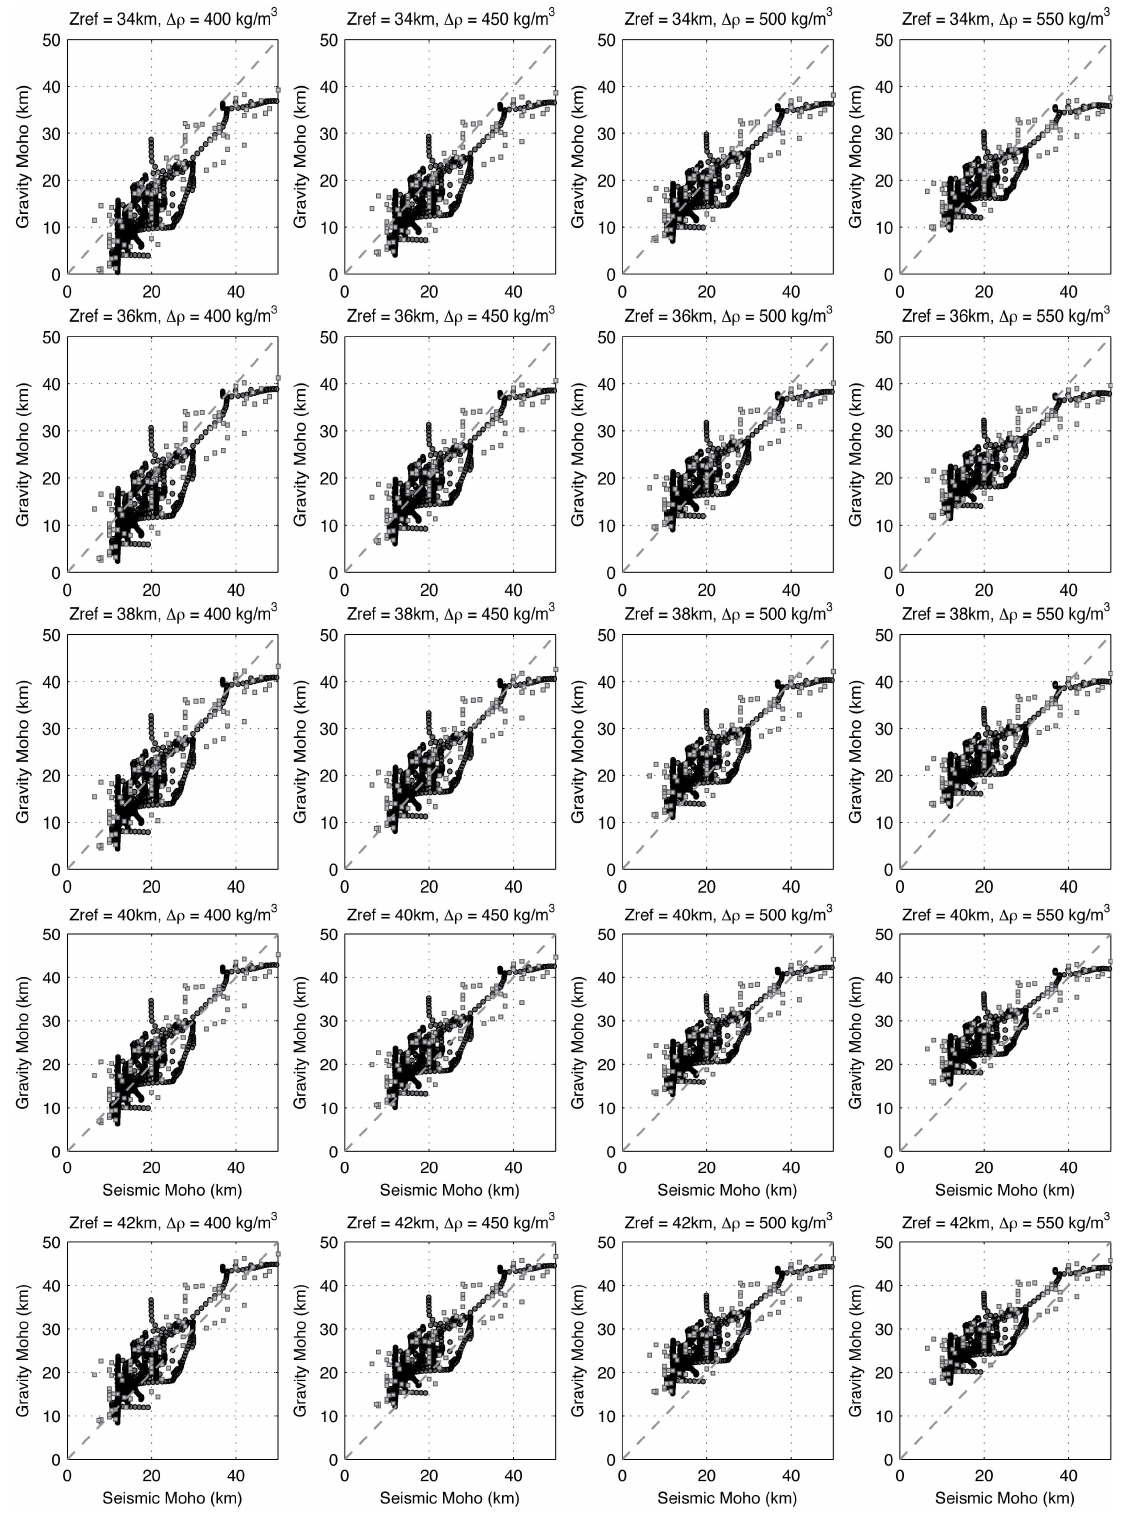
Fig. A1. Verification of the credibility of gravity inversion method and the resulting crustal thickness grid. The results were tested by different combinations of reference Moho depths (Zref) and crustal densities ( 1ρ ). The gravity Moho in each combination (circles) has been plotted against the depth to Moho derived from independent seismic refraction profiles and receiver functions (squares) to examine their correspondence and